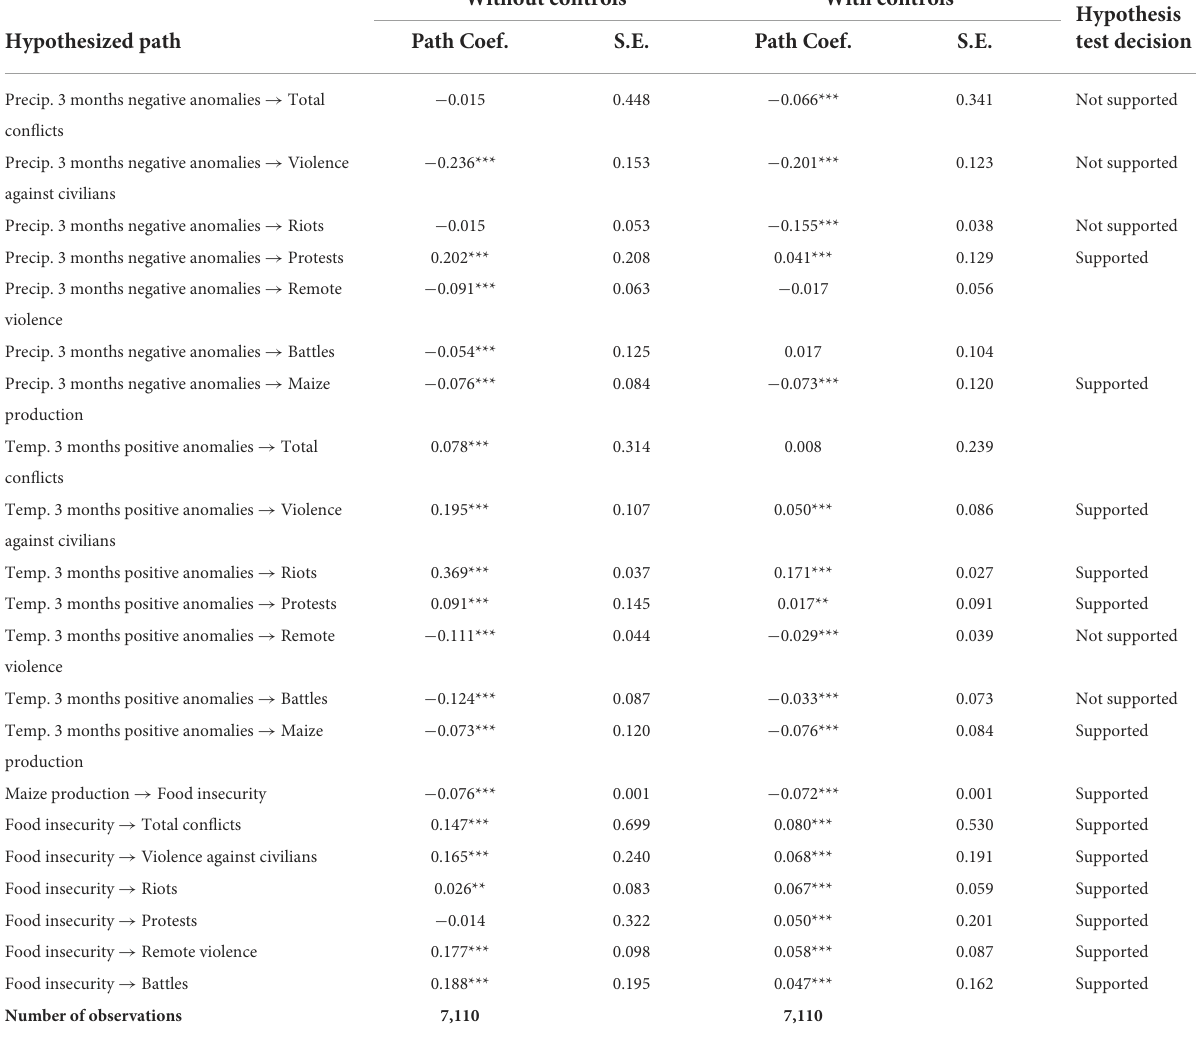
TABLE 1 Selection of results of the econometric model showing the direct effects of climate, maize production, food insecurity and conflict, without control variables (col. 2) and with control variables (col. 3). The last column shows whether the results support the hypotheses of our theoretical background presented in section